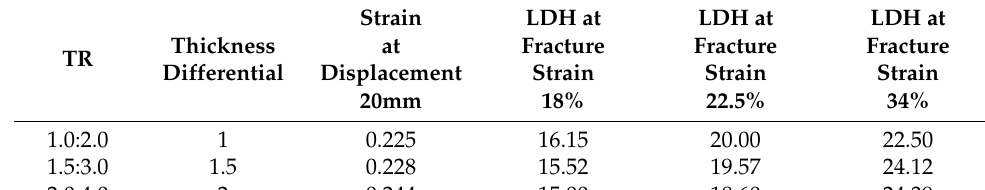
Table 4. Simulation results when thickness ratio fixed as 1:2.